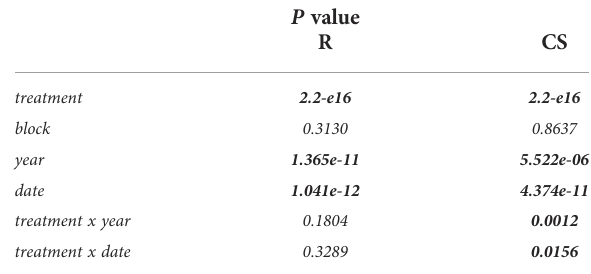
TABLE 1 Results of the multi-factor analysis of variance (ANOVA) and Tukey ’ s honestly signi fi cant difference (HSD) test for net assimilation of the two cultivars Riesling (R); Cabernet Sauvignon (CS) over the two seasons and measuring dates. Signi fi cant differences appear at P ≤ 0.05 level and are displayed in bold